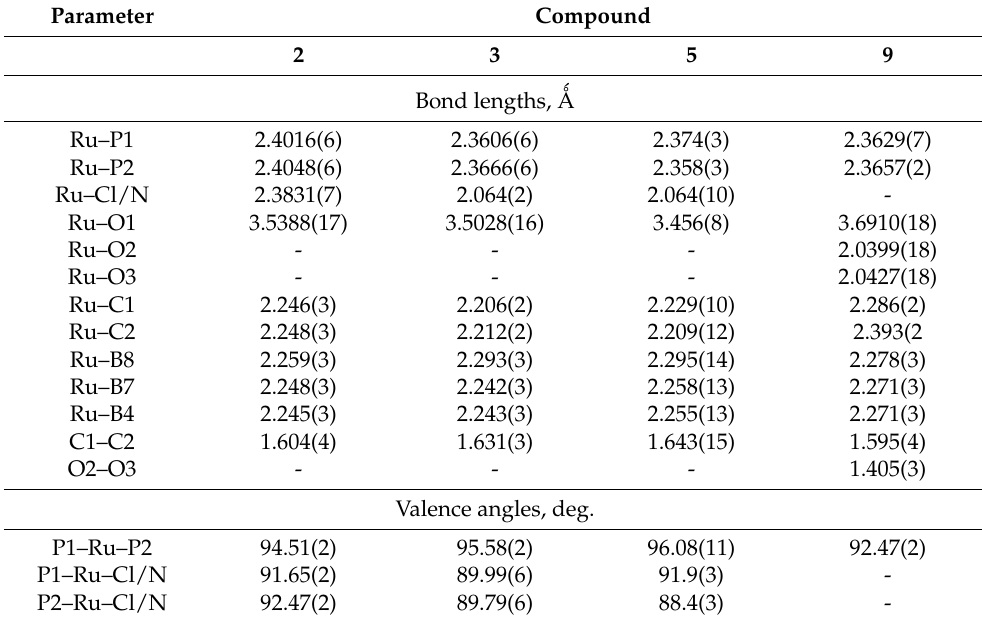
Table 1. Selected bond lengths (Å) and angles (deg.) in the discussed ruthenacarboranes. Parameter